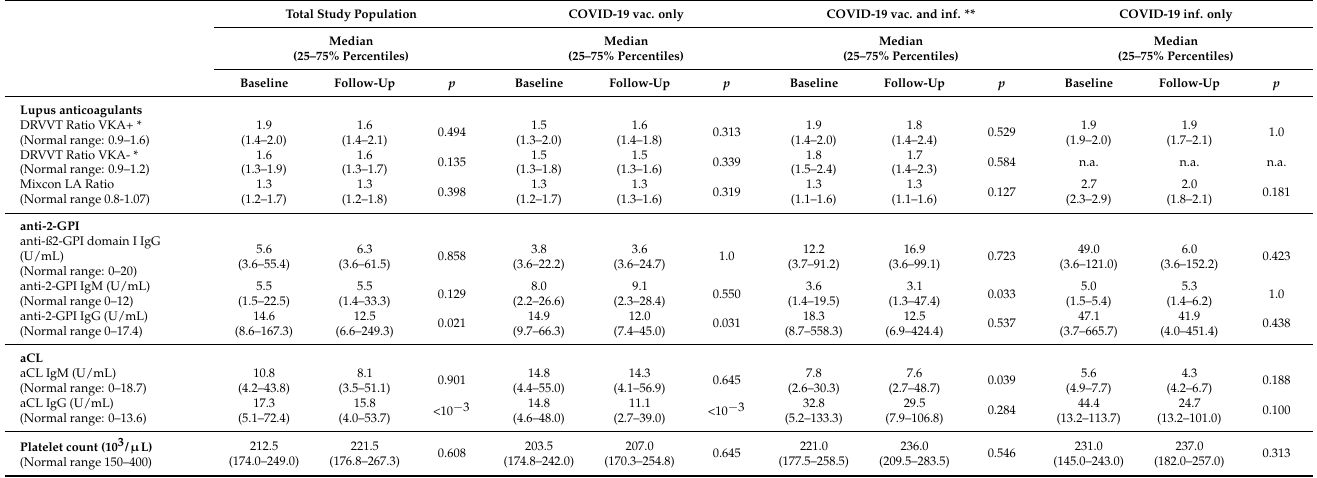
Table 4. Effect of COVID-19 vaccination and/or infection on antiphospholipid antibodies and platelet count. Comparisons of different parameters at baseline and